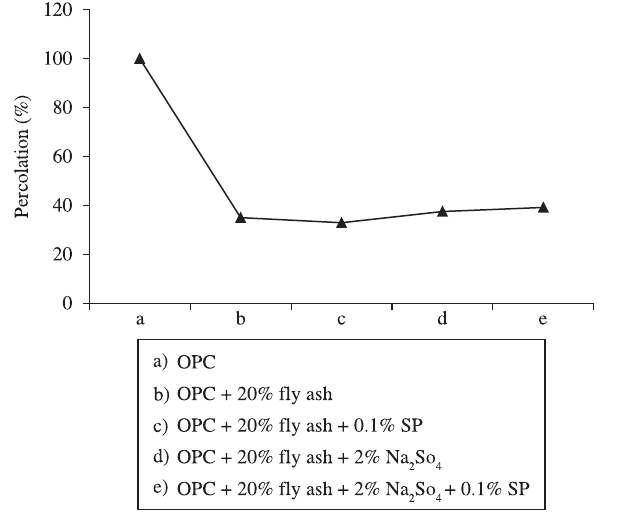
Figure 5. Water percolation in different system.